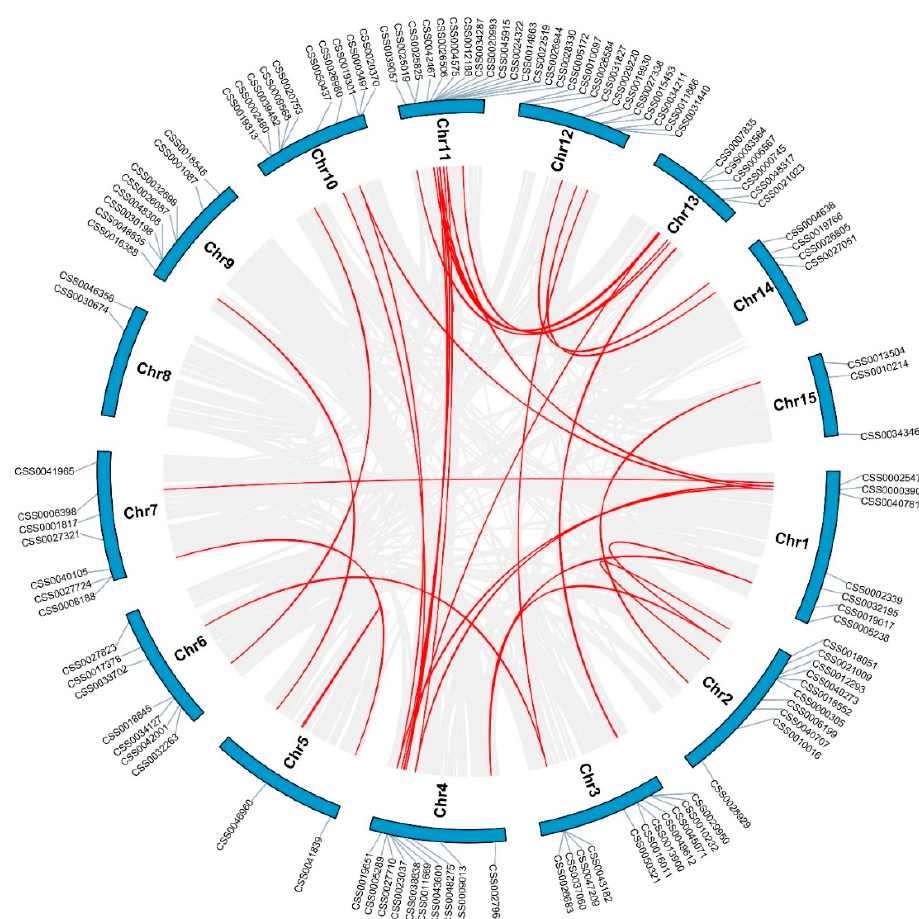
Figure 3. A syntenic relationship among CsC2H2-ZFP homologous genes was presented on the genome of C. sinensis . Gray lines indicate all synteny blocks and red lines indicate segmentally duplicated genes in C. sinensis genome. The chromosome number and gene names are presented.